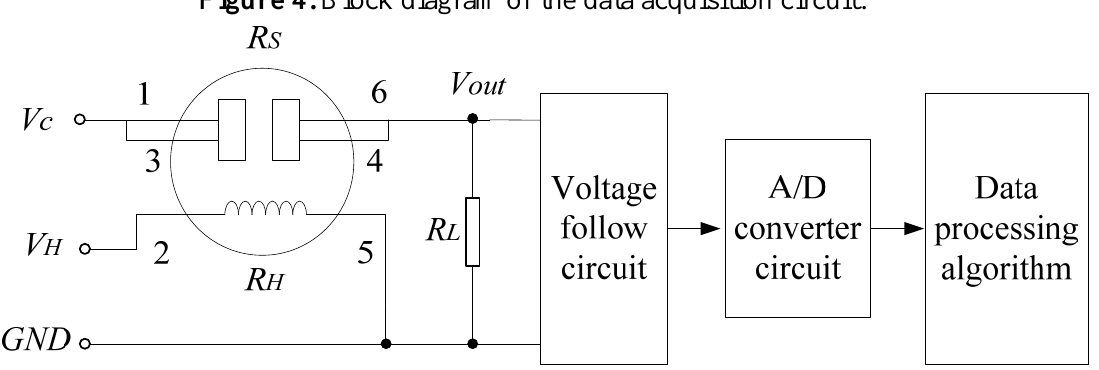
Figure 4. Block diagram of the data acquisition